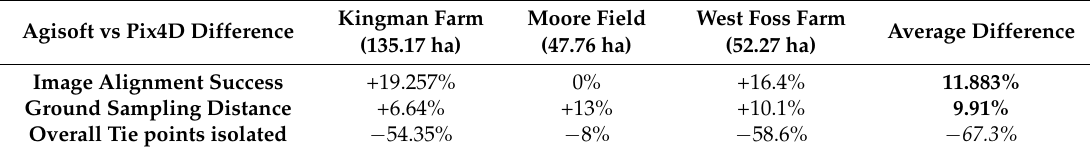
Table 2. SfM software output comparison for Agisoft PhotoScan and Pix4D mapper Pro. Pix4D is set as the baseline with improved (bold) and diminished (italic) results shown for Agisoft processing. Agisoft vs Pix4D